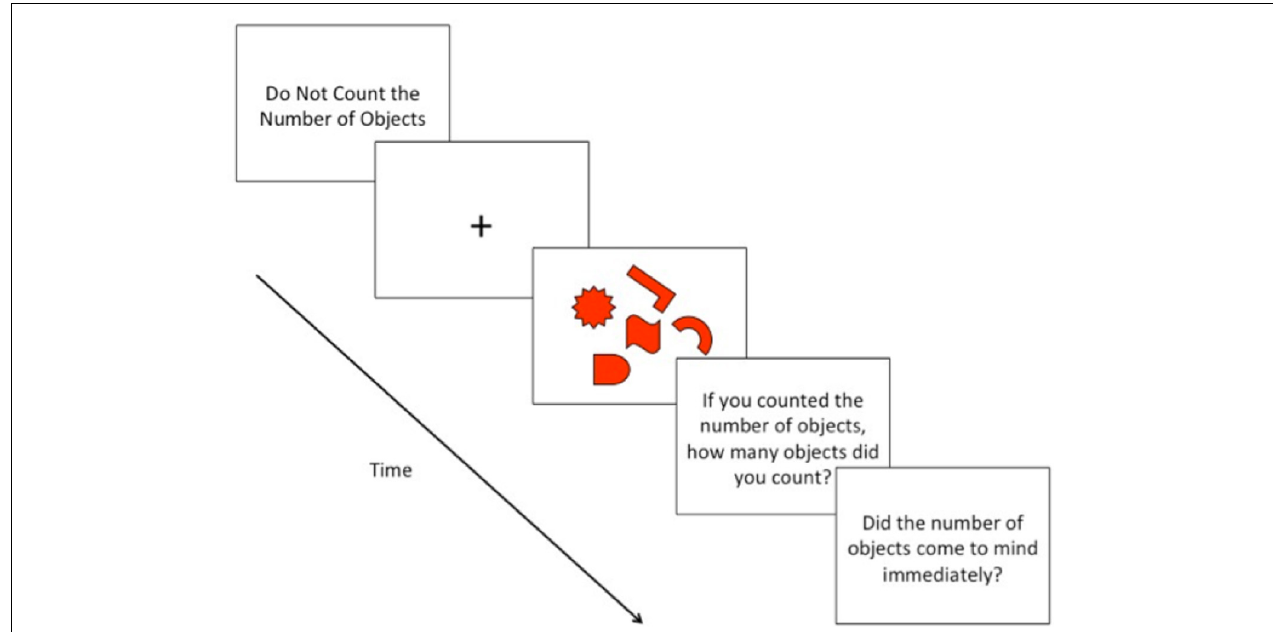
FIGURE 1 | Schematic depiction of a typical trial with an array of objects that are all presented in the same color.